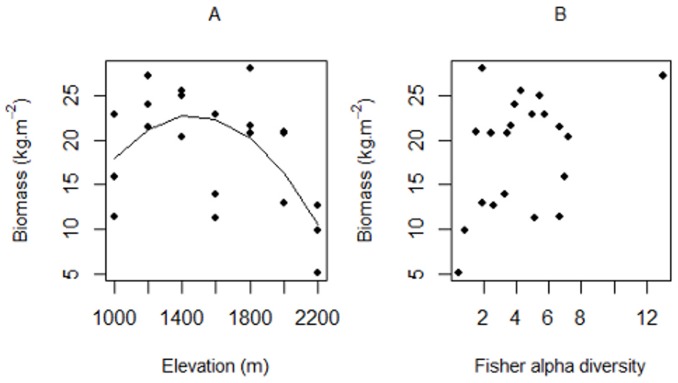
Relationships between above ground biomass and (A) elevation (y = 18.81-11.35x-14.32 x2, R2 = 0.35, all stations 2200 m included), and (B) diversity (fisher's alpha) of subcanopy and canopy vegetation combined on Mount Rinjani, Indonesia.Solid lines indicate relationships including all elevation stations and the dashed lines indicate relationships when the station at 2200 m (fire-maintained grassland) was omitted. Only significant (p<0.05) relationships are shown.